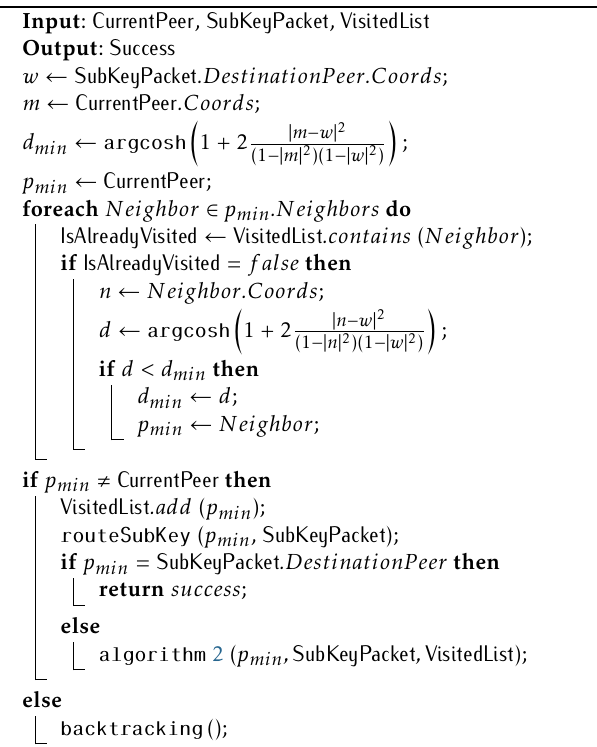
Algorithm 2: Routing a subkey in a CLOAK network.